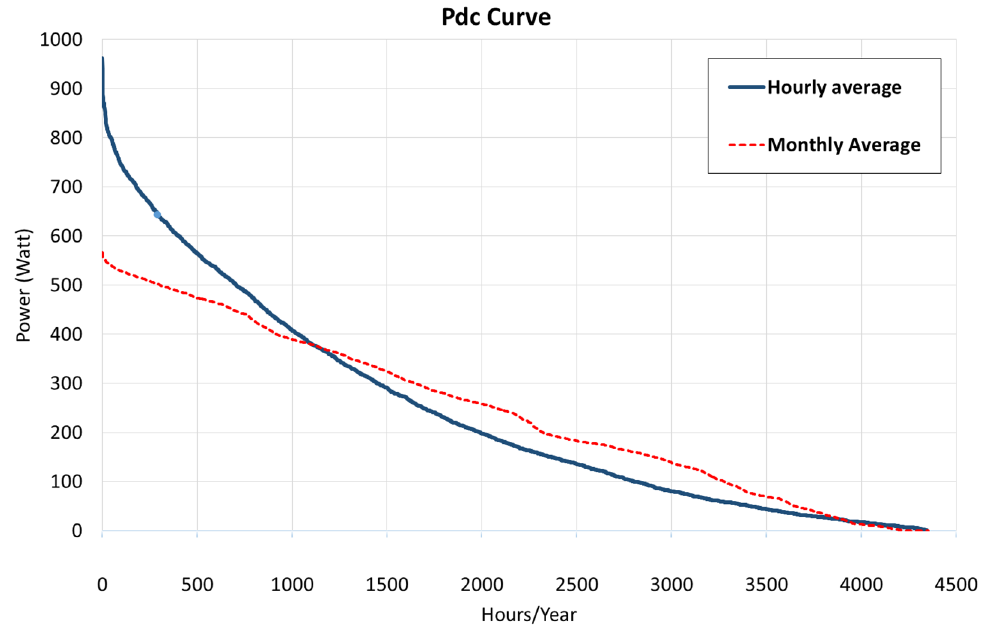
Figure 2. P DC duration curves, calculated from monthly and hourly average solar irradiance values (Paris: azimuth 0°; tilt